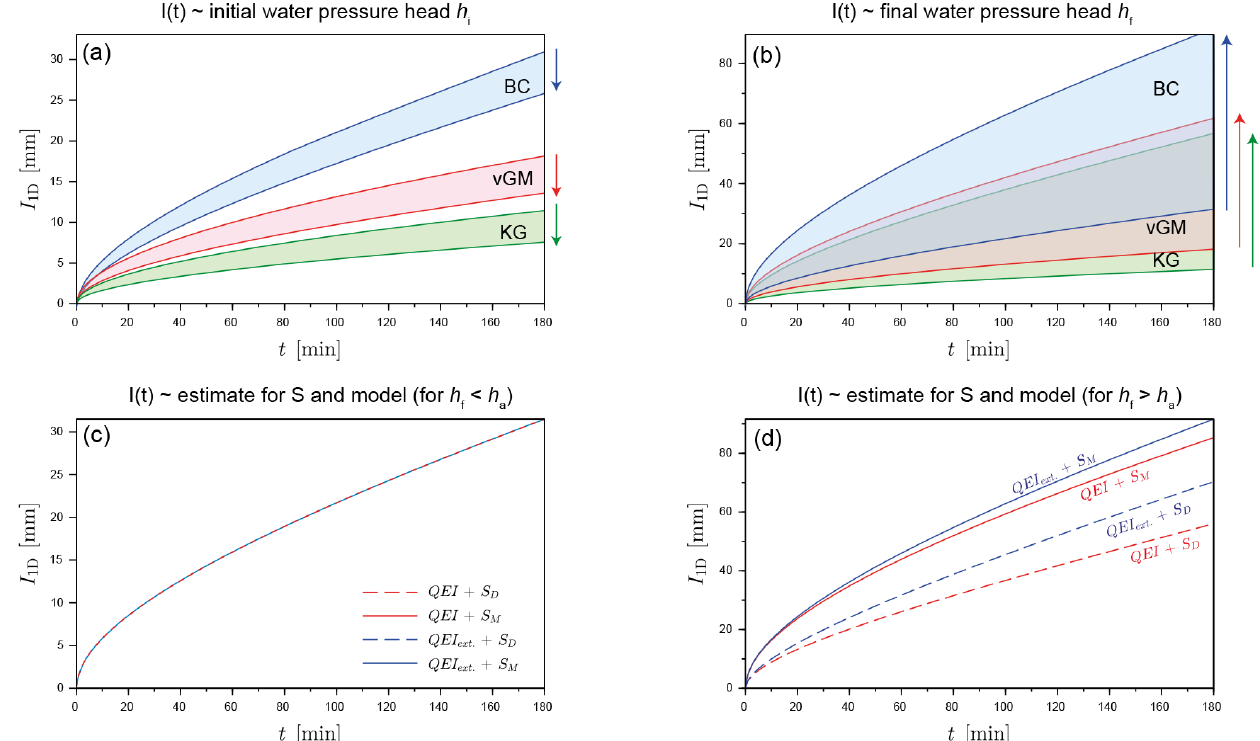
Figure 8. Cumulative infiltrations as a function of initial (a) and final (b) water pressure heads, computed with the correct estimate for sorptivity ( S M ) and the right model and illustration of the dependency of cumulative infiltration on the model selection (QEI model versus extended QEI_ext model) and on the selected estimator for the sorptivity ( S M versus S D ) for (c) the case of unsaturated conditions imposed at surface h f ≤ h a (BC model, h i = − 10m and h f = − 150mm) and (d) the case of saturated conditions, h f ≥ h a (BC model, h i = − 10m and h f =